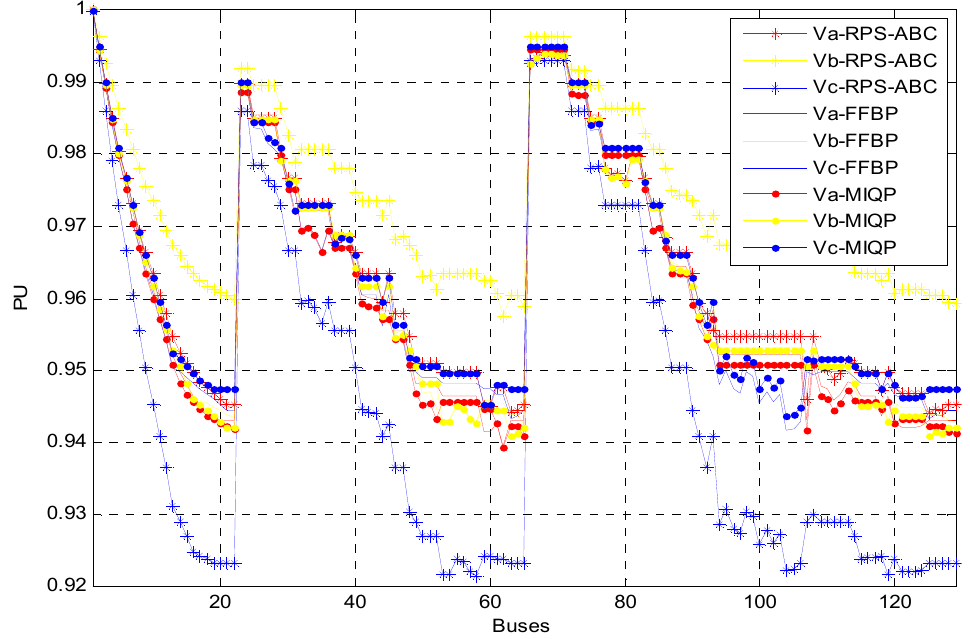
Figure 9. Voltage profile of the low voltage distribution system at peak load.